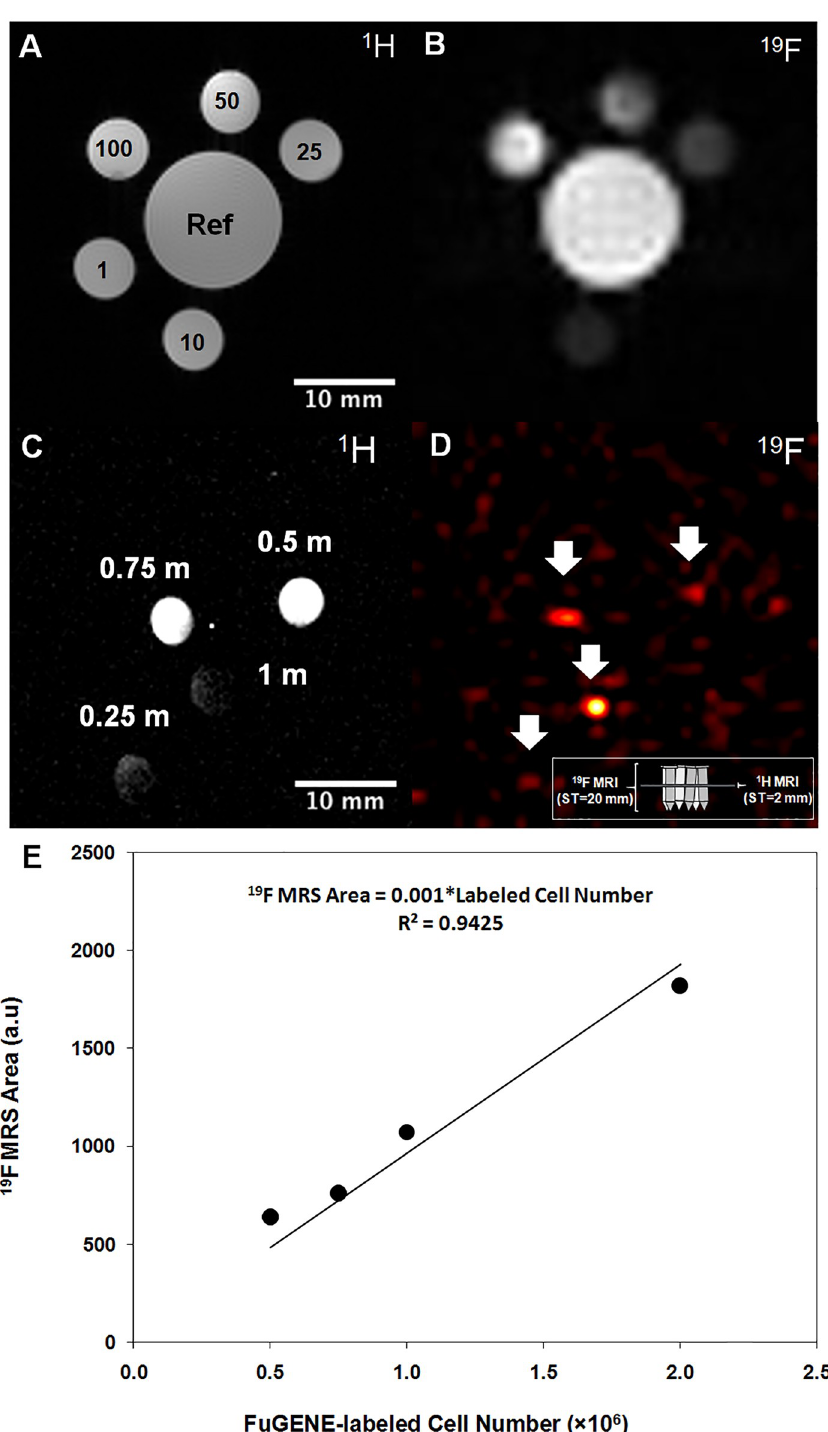
Fig 5. CPC label confirmation using flow cytometry and in vitro 19 F MRI/MRS validation. (A, B, D, E) Ungated scatter plots of forward (FSC) and side scatter (SSC, singlets vs. doublets) and (C, F) gated, overlapped flow cytometry histograms of control (C) and labeled CT cells (F) confirming cellular uptake. Applied gates are indicated in the scatter plots as highlighted regions-of-interest. (G, H) Confocal microscopy images of PFCE labelled (G) CDC GFP+ (calcein [gray]), (H) Atto647 (red), and (I) merged calcein/Atto647 with a zoomed inlet indicating the heterogenous distribution of cellular label uptake. (J, K) Corresponding 19 F and 1 H- 19 F merged MRI of labeled CT cells (~4.5